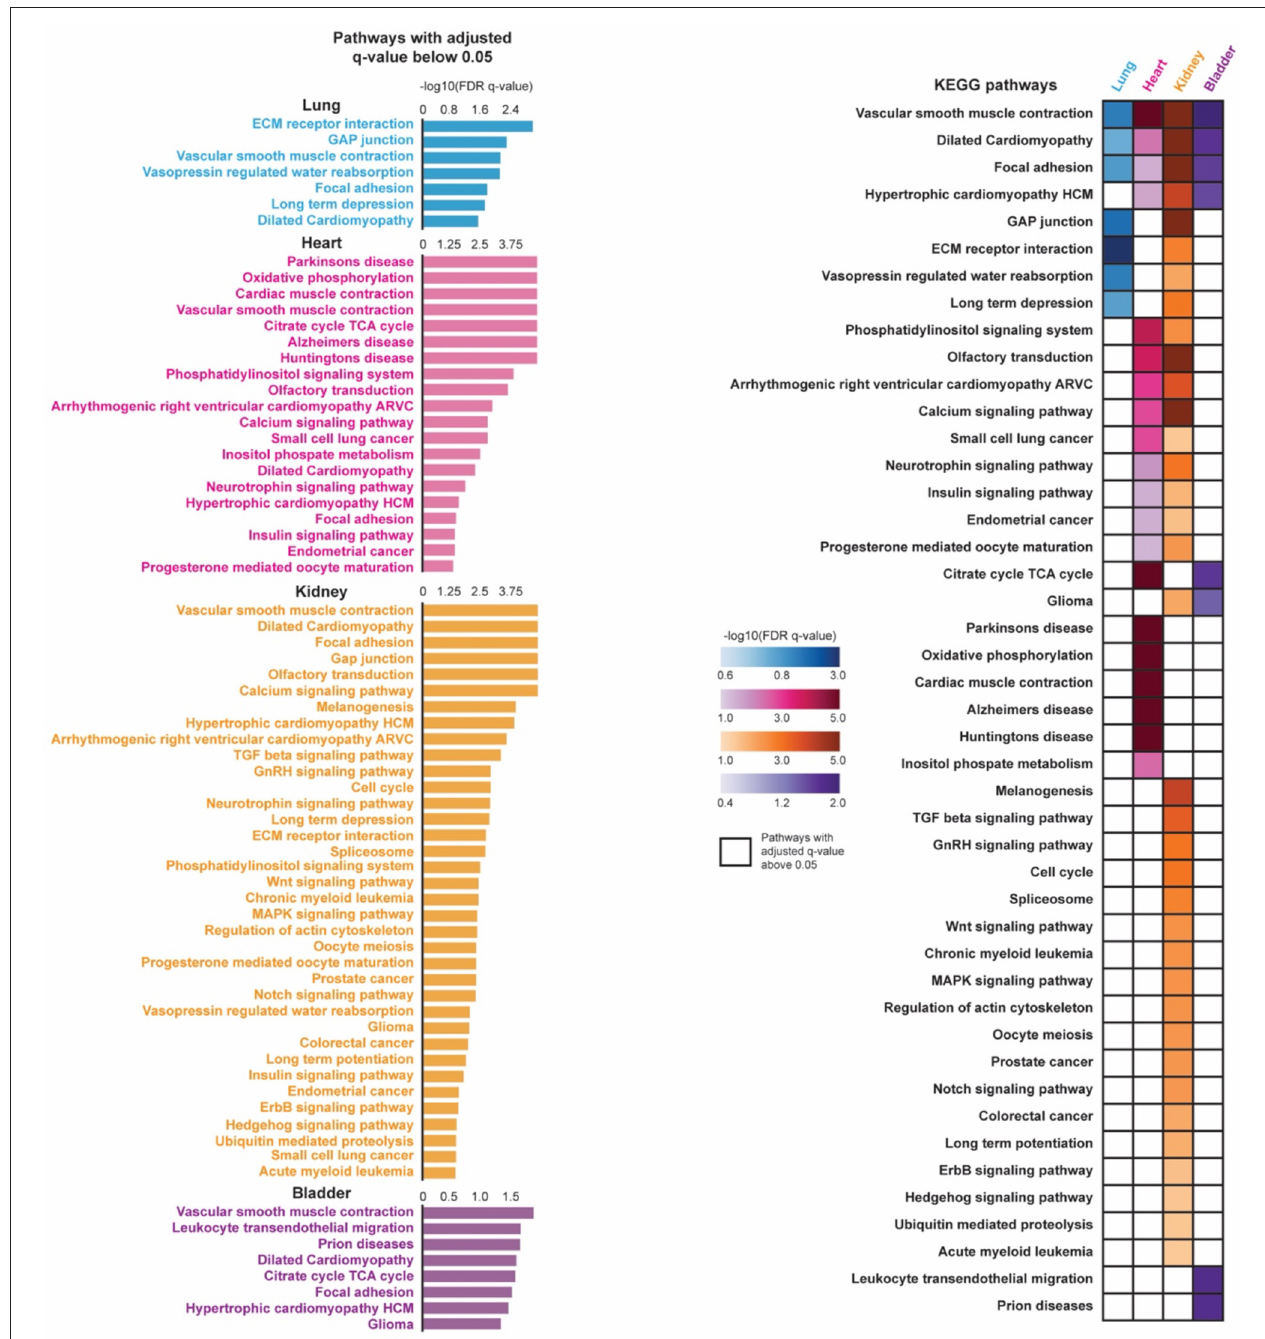
FIGURE 3 | Pathway enrichment analysis of pericytes in four organs are shown. Pre-ranked gene set enrichment analysis (GSEA) with the Kyoto Encyclopedia of Genes and Genomes (KEGG) pathway database was conducted on the DE genes between the tissue-specific stringent pericytes and all other cells of its corresponding tissue. The DE genes were sorted based on their average log2(Fold Change) in a descending order to generate the pre-ranked gene list. Enriched pathways were identified for each tissue-specific stringent pericytes based on their adjusted q-value ( q < 0.05). The identified enriched pathways of the tissue-specific stringent pericytes were compared across four tissue